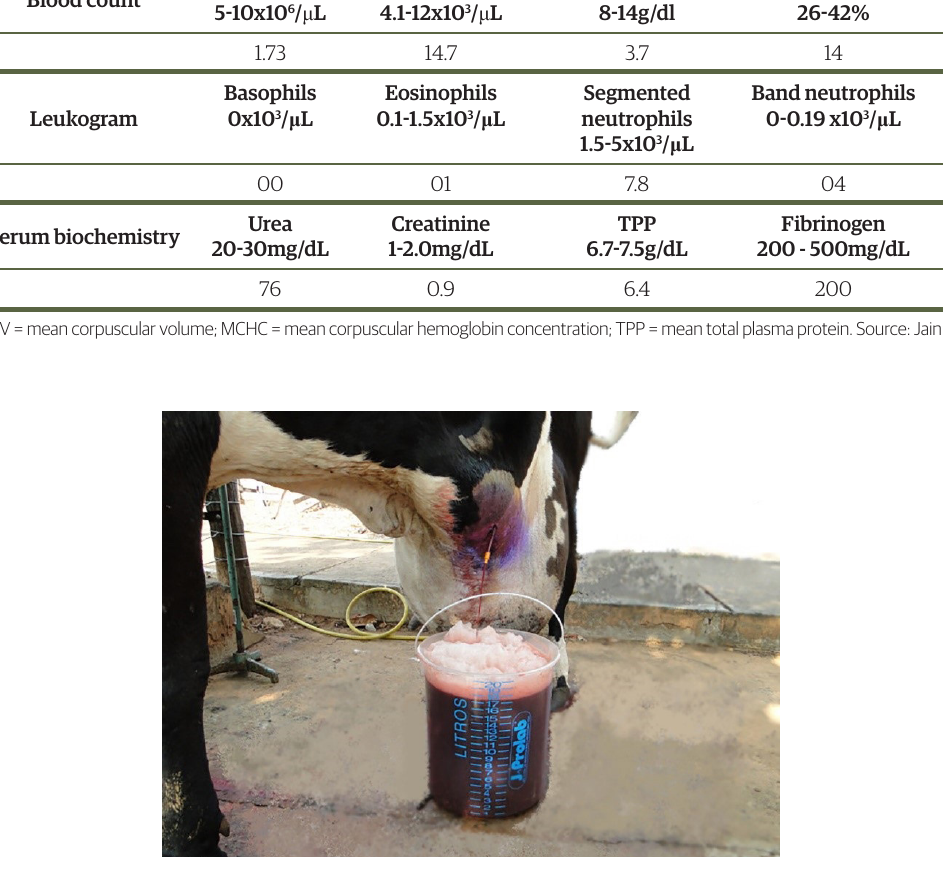
Table 1. Blood count results and serum biochemistry of a Holstein cow with clinical mastitis, udder edema, and rupture of the mammary vein. Hemat. Blood count